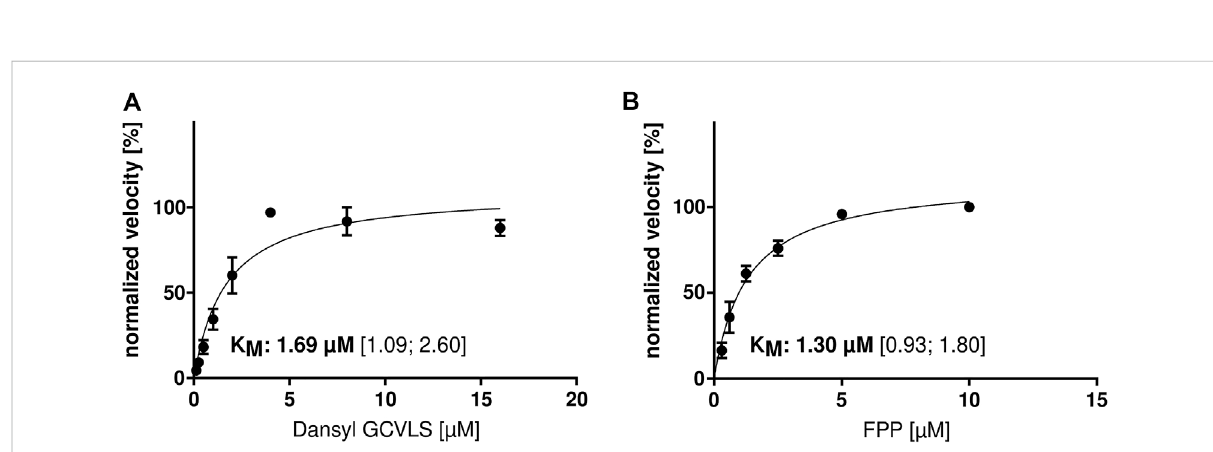
FIGURE 2 K M determination of ce FTase. Determination of the K M for (A) Dansyl-GCVLS (with fi xed [FPP]) and (B) FPP (with fi xed [Dansyl-GCVLS]). The change in fl uorescence was measured and the mean ± SEM of the normalized velocity plotted against the substrate concentration. The K M and the 95% con fi dence interval (CI) are